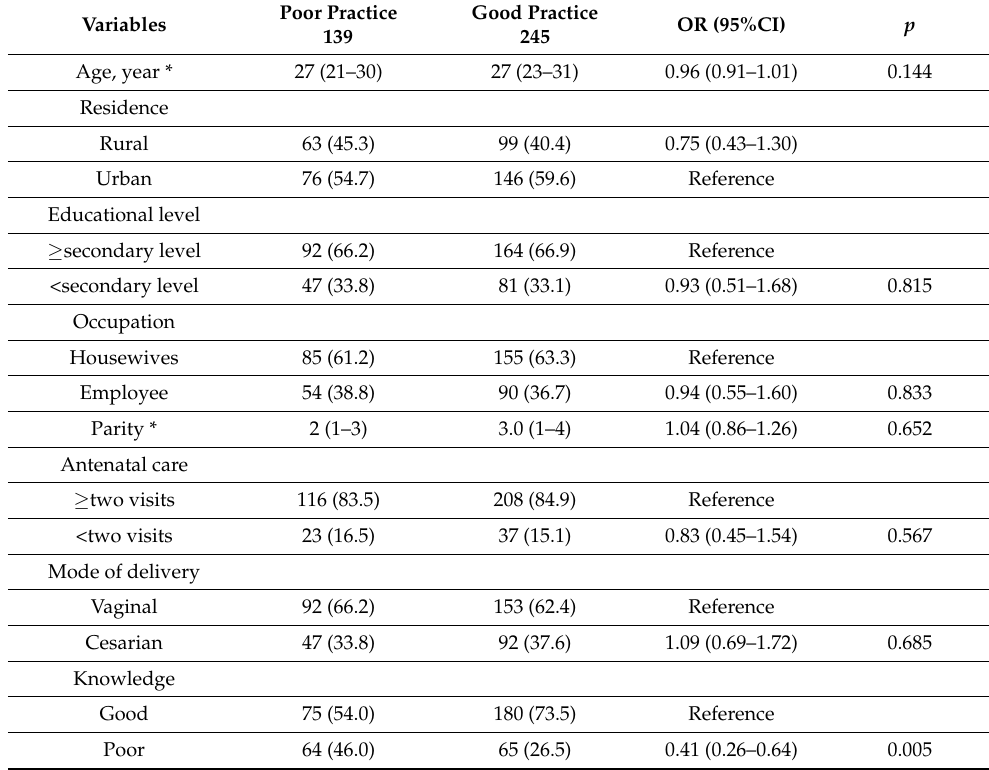
Table 4. Factors associated with participants’ practices of